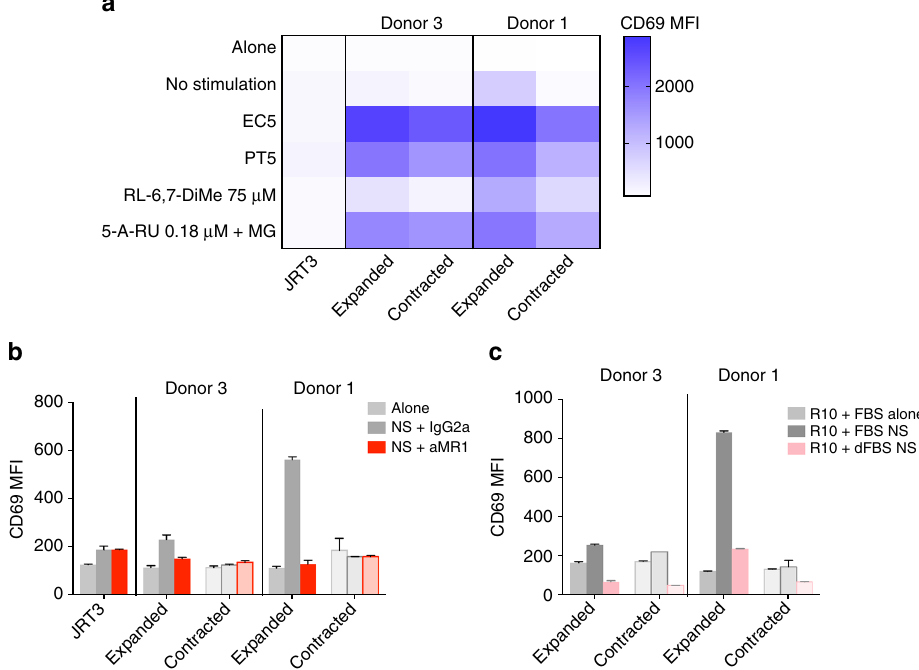
Fig. 5 Greater activation of Jurkat.MAIT cells expressing TCR β clonotypes expanded after enteric fever. Jurkat.MAIT cell lines expressing the TCR β chain of clonotypes that either expanded or contracted in diagnosed donor 1 and donor 3 were produced. Using C1R.MR1 cells as antigen-presenting cells, the activation of Jurkat.MAIT lines was measured by fl ow cytometry using the MFI of CD69 in response to in vitro bacterial supernatant and ligand stimulation when co-cultured for 18 – 20 h. a Heatmap of CD69 expression on Jurkat.MAIT cell lines when co-cultured with 5 μ L E. coli (EC) supernatant, 5 μ L S . Paratyphi A (PT) supernatant, 0.18 μ M 5-amino-6-( D -ribitylamino)uracil (5-A-RU) with 10 μ M methylglyoxal (MG) and 75 μ M 6,7-dimethylribityl lumazine (RL-6,7-DiMe). b Baseline activation of Jurkat.MAIT cell lines when co-cultured without stimulus added and c with normal vs. dialyzed FBS. For blocking experiments, 10 μ g/mL of MR1 blocking antibody (aMR1) or IgG2a isotype control was added. Bars show mean with error bars representing SEM between technical duplicates. Results are representative of at least two independent experiments. MFI, mean fl uorescence intensity; NS, no presented in Table 1. The Jurkat.MAIT gating strategy, V α 7.2 expression and CD3 mean fl uorescence intensity (MFI) overlay (ensuring comparable levels of surface TCR across the Jurkat. MAIT line pairs) are shown in Supplementary Figs. 10 and 11,